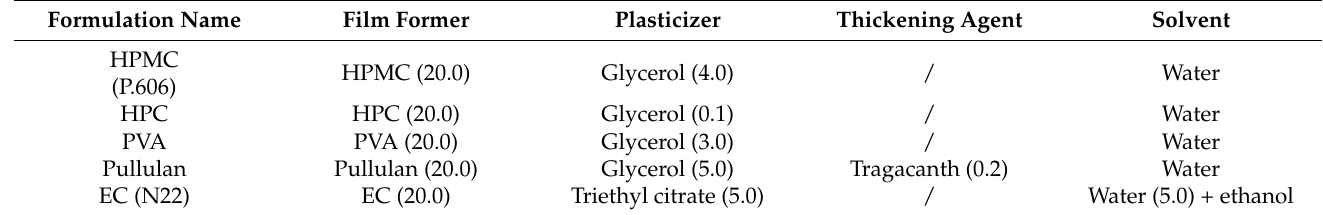
Table 2. Prepared film formulations (selection, % w / w , N22: Aqualon TM